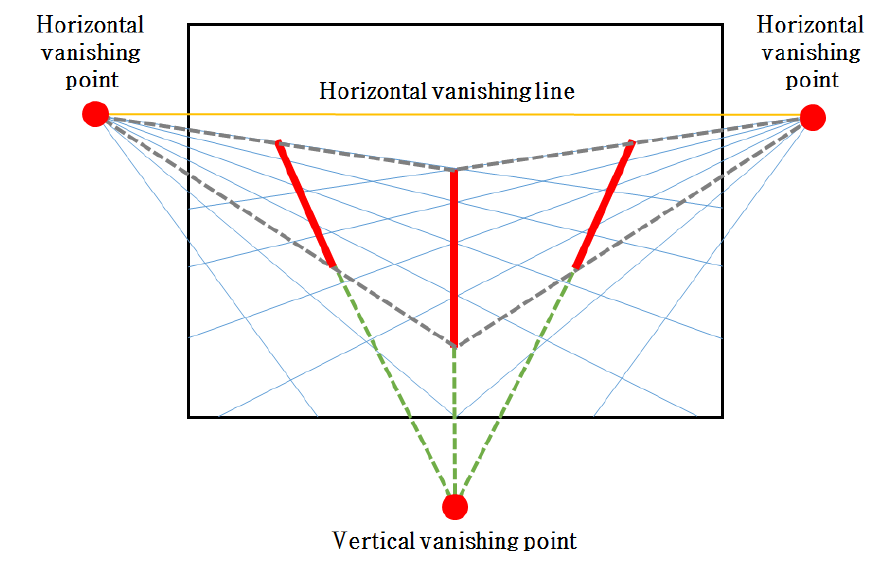
Figure 5. Definition of vanishing points and the horizontal vanishing